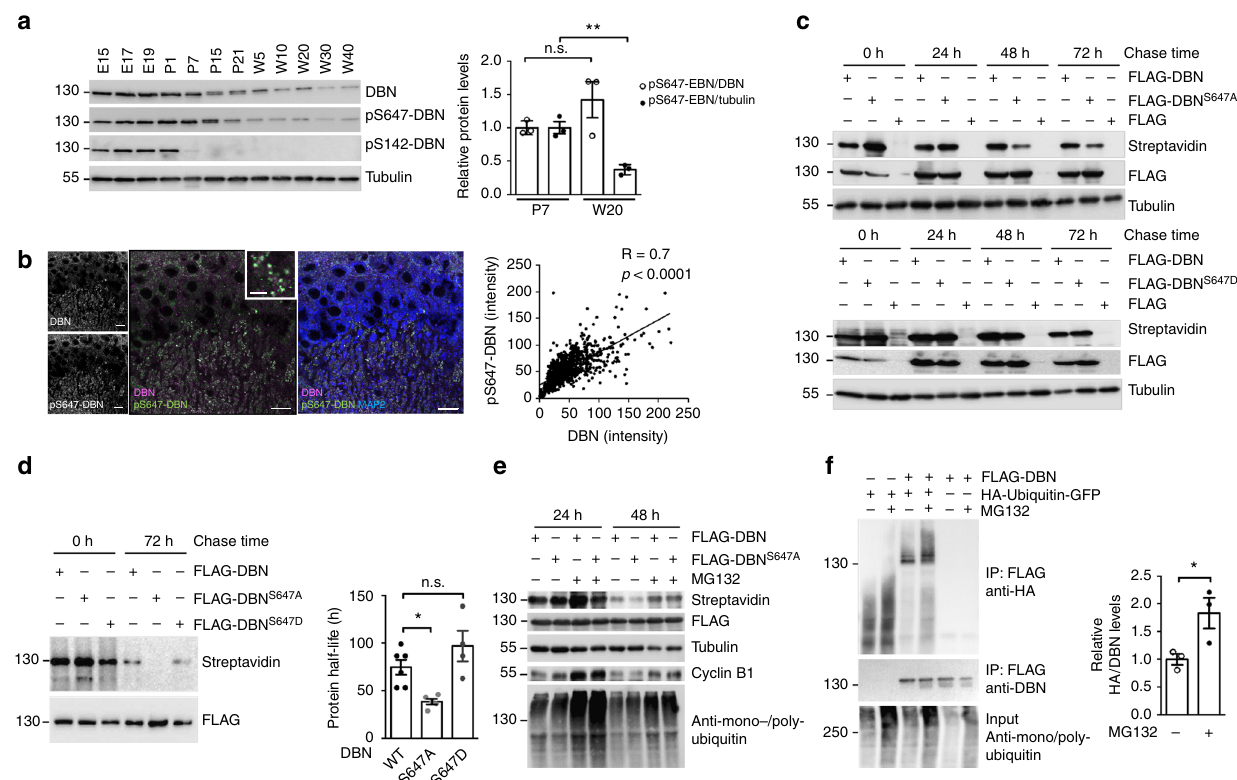
Fig. 2 DBN stability is regulated by phosphorylation and ubiquitination. a Developmental expression of DBN and phospho-DBN in the rat brain. Left: western blot analysis of rat brain protein lysates. E: embryonic day; P: postnatal day; W: week. Molecular weight protein ladder is in kilodaltons. Right: quantitative analysis of pS647-DBN protein levels at P7 and W20 relative to DBN or to tubulin. n = 3 independent animals. Mean±SEM. One-way ANOVA Bonferroni test. ** p < 0.01. n.s.: non-signi fi cant. b Immunohistological analysis of DBN (magenta), pS647-DBN (green) and MAP2 (blue) at P7 in the CA3 region of the mouse hippocampus. Scale bars: 20 μ m. Insert demonstrates the overlap of DBN and pS647-DBN immunolabelling in synapses. Scale bar insert: 10 μ m. Right: correlative curve between the intensity of DBN and the intensity of pS647-DBN. N = 4, n = 1044. Spearman's correlation coef fi cients r and p values are indicated. c Analysis of DBN protein stability in terms of dependence of phosphorylation at S647. HEK 293T cells were transfected with FLAG constructs, labelled with AHA for 1 h and chased for 24, 48 or 72 h. Labelled protein was detected with streptavidin, total transfected protein with anti-FLAG antibodies (S647A top; S647D bottom) and total protein amount with anti- α -tubulin antibodies. d Determination of DBN wild-type, DBN S647A and DBN S647D protein half-life in HEK 293T cells. Mean ± SEM, * p < 0.05. WT: n = 6, S647A: n = 5, S647D: n = 6. n = biologically independent experiments. One-way ANOVA Bonferroni test. * p < 0,05, n.s.: non-signi fi cant. e DBN degradation is proteasome-dependent. Pulse-chase assay in the presence of vehicle DMSO ( − ) or MG132 ( + ). Note the increase in cyclin B1 levels and in mono polyubiquitinated proteins in the presence of MG132. f DBN is ubiquitinated. HEK 293T cells expressing FLAG-DBN and HA-ubiquitin-GFP constructs were treated with DMSO ( − ) or MG132 ( + ). Left: western blot analysis of immunoprecipitated FLAG-DBN detecting HA-ubiquitinated conjugates. Right: quantitative analysis of HA conjugates relative to immunoprecipitated FLAG-DBN. n = 3 biologically independent experiments. Mean± SEM. T test * p < 0.05. DBN developmentally regulated brain protein, DMSO dimethyl sulfoxide, ANOVA analysis of